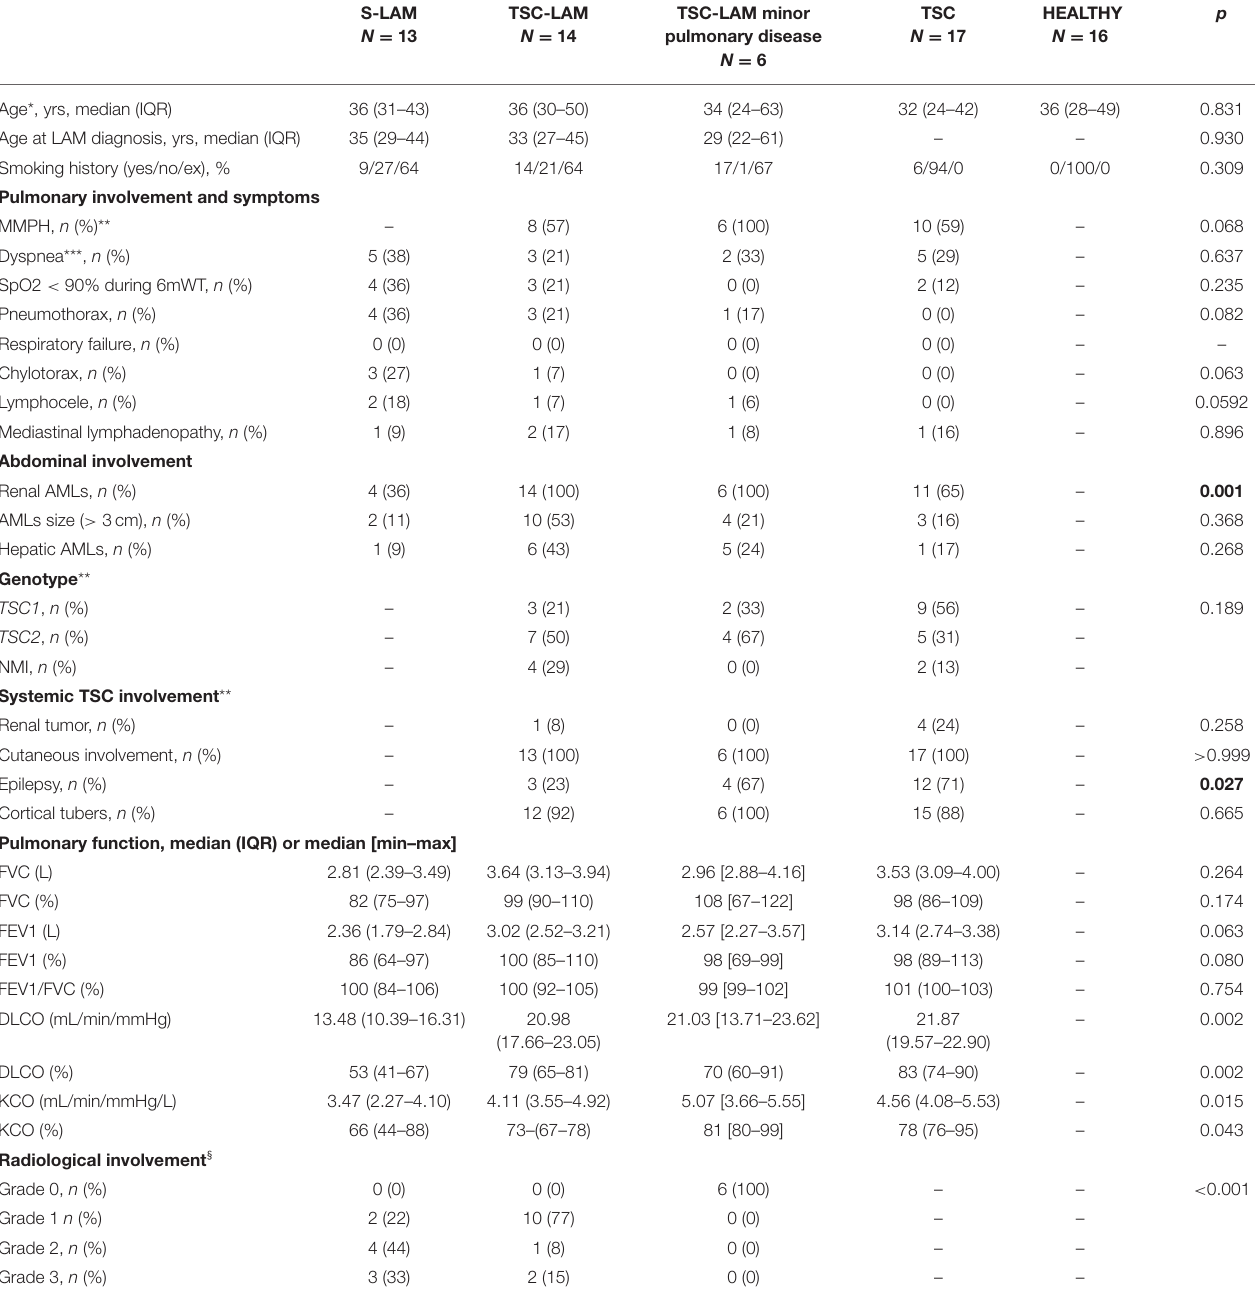
TABLE 1 | Demographic and clinical characteristics of the population in